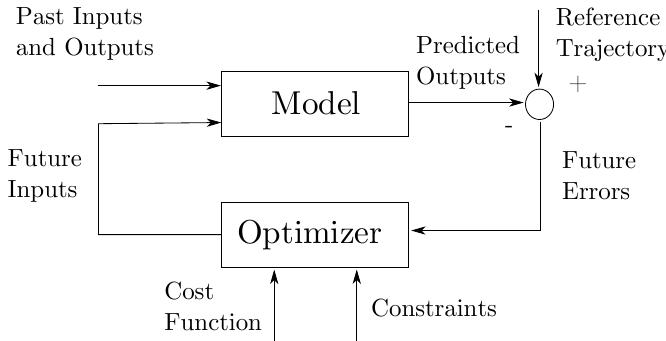
Figure 6. Basic Structure of Model Predictive